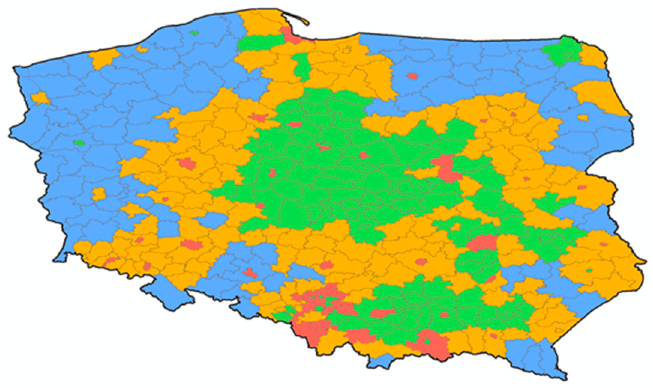
Figure 7. Poland, districts classification according to share of LS reliability classes.